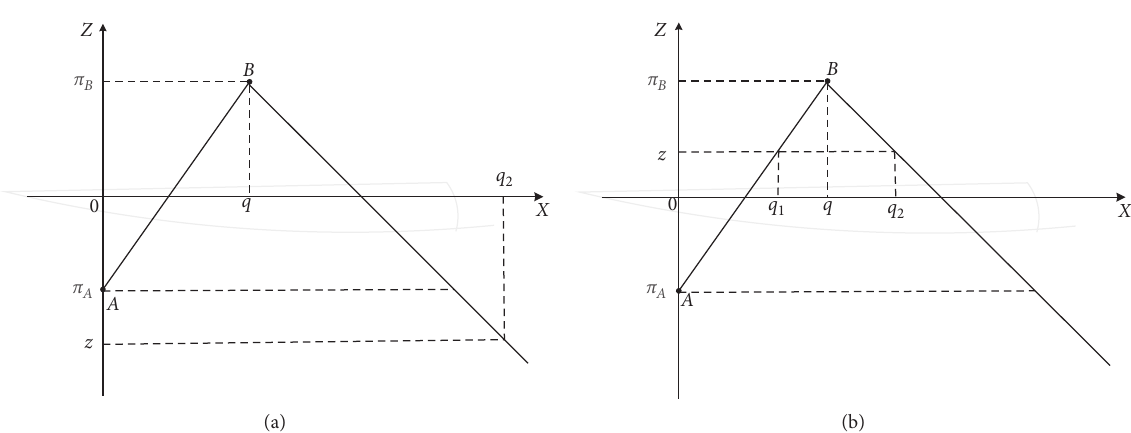
Figure 2: Schematic diagram of the relationship between stochastic demand and profit under the risk-seeking retailer managed inventory mode in the water supply chain. (a) z ≤ π A . (b) z ∈ ( π A , π B ]